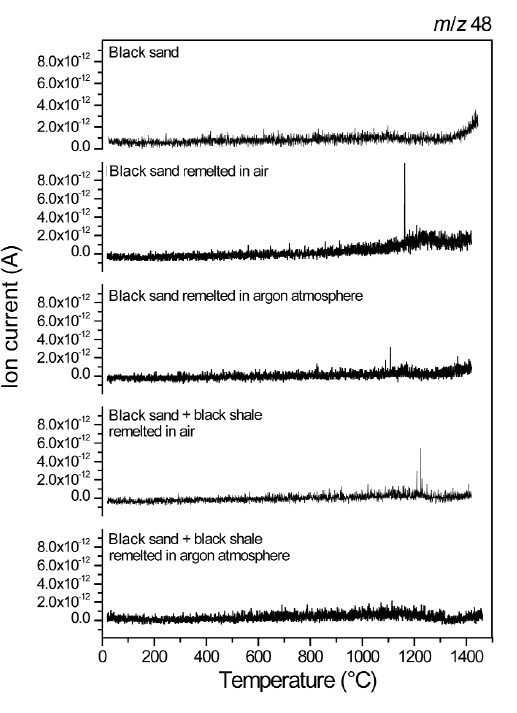
Fig. 12. Change of the partial pressure of mass number m / z = 48 (SO +